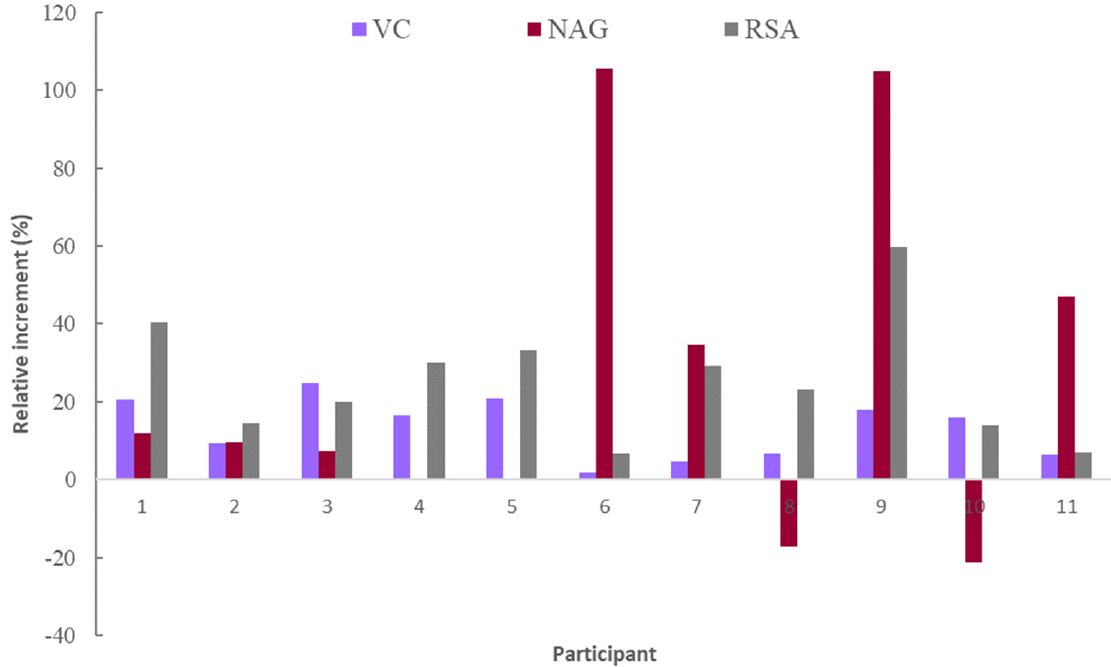
Figure 3. Relative increase, related to fasting level, in serum blood vitamin C (VC), naringenin (NAG), and radical scavenging ability (RSA) due to reconstituted spray-dried juice intake by each participant.